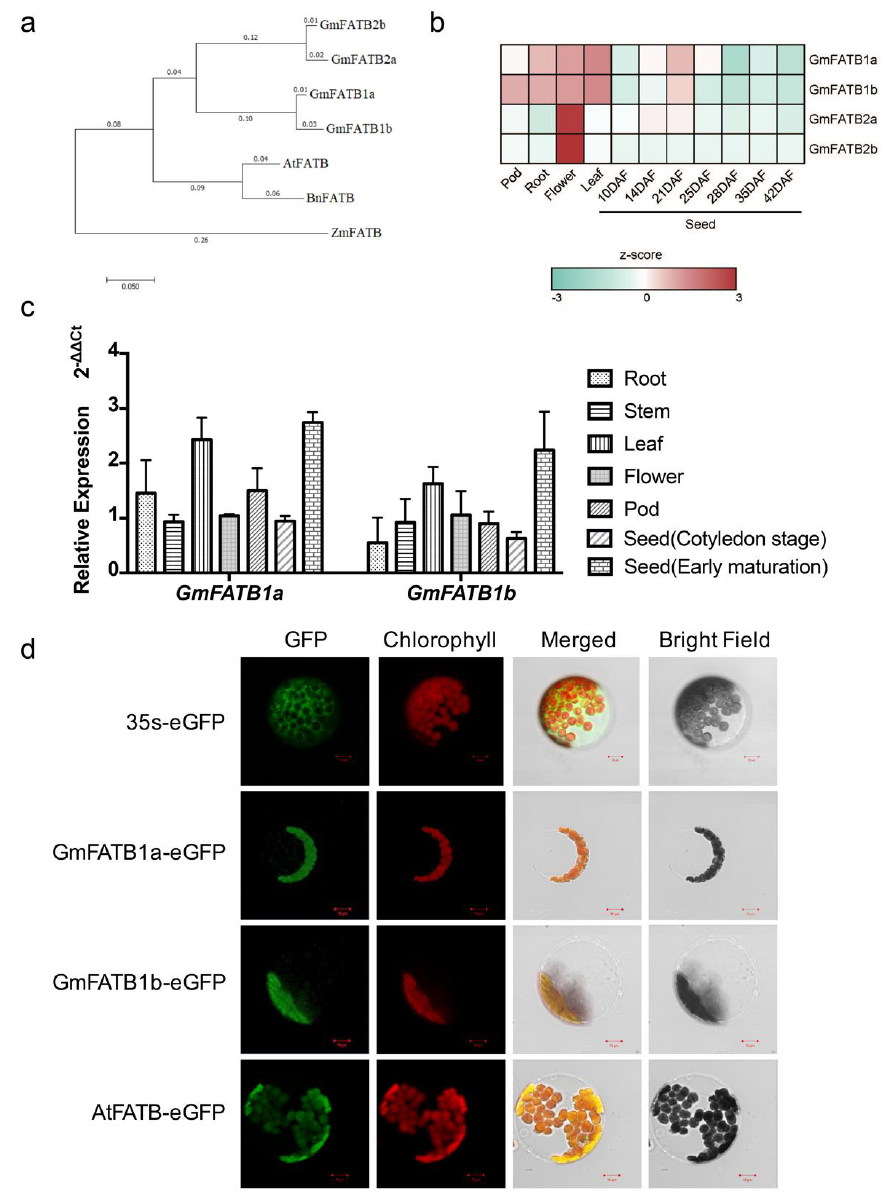
Figure 1. Characterization of the FATBs from soybean. ( a ) Phylogenetic analysis of FATBs from different species. Amino acids sequences were aligned by Clustal W and the phylogenetic tree was constructed based on the construct Neighbor-Joining Tree, using MRGA 6.0(At, Arabidopsis thaliana ; Gm, Glycine max ; Zm, Zea mays ; Bn, Brassica napus ). ( b ) GmFATBs expression pattern diagram. Using TBtools software, the z-score further normalized the FPKM value of each gene in different tissue samples and we then drew a heat map. ( c ) FATB1a and FATB1b were constitutively expressed. Total RNA from soybean Williams 82 was extracted from different tissue. Seeds at the cotyledon stage correspond to 10–14 days after fertilization. The early maturation stage is represented by 15–20 days after fertilization. The transcript levels were detected by qRT-PCR and calculated relative to GmACTIN (Glyma.08G146500). The relative expression level was calculated using the transcript abundance of the gene in tissue of “Stem”. The left panel is GmFATB1a (Glyma.05G012300). The right panel is GmFATB1b (Glyma.17G012400). ( d ) Subcellular localization of GmFATB1a/1b in Arabidopsis protoplasts. Green represents the fusion protein fluorescence, and red represents chloroplast autofluorescence. Scale bar = 10 μm.